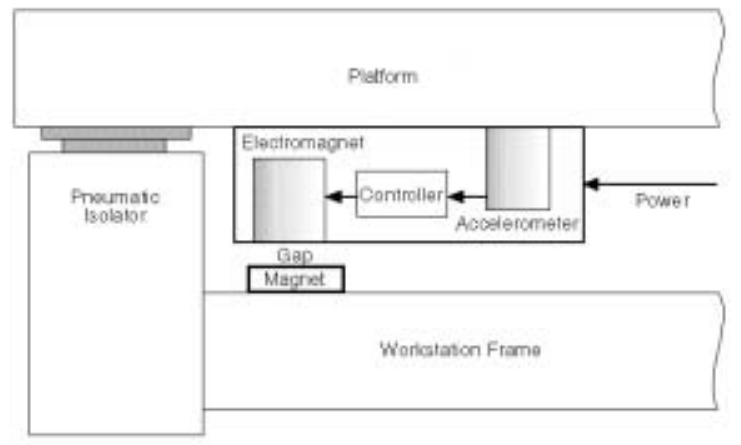
Fig. 8. Design and installation of the electromagnetic damper in a pneumatic